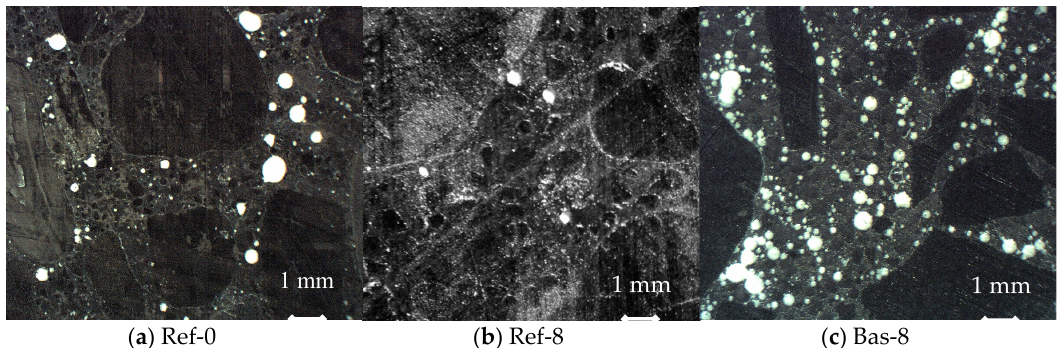
Figure 2. Cross-sections of specimens prepared for optical porosimetry tests.